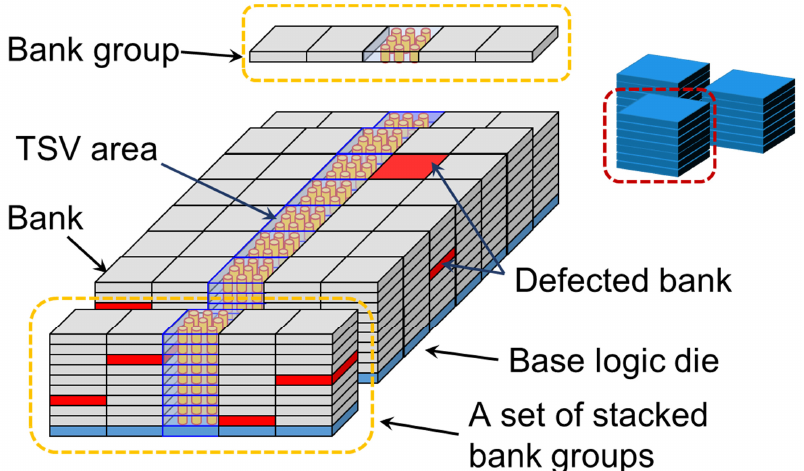
Figure 48. Schematic diagram of typical configuration of stacked DRAM devices. The circuit design hierarchy of BBCube is common. Each die consists of banks. These banks include not only sub-arrays for memory capacity, but also redundant sub-arrays to replace defective sub-array(s) to perform 2D redundancy.